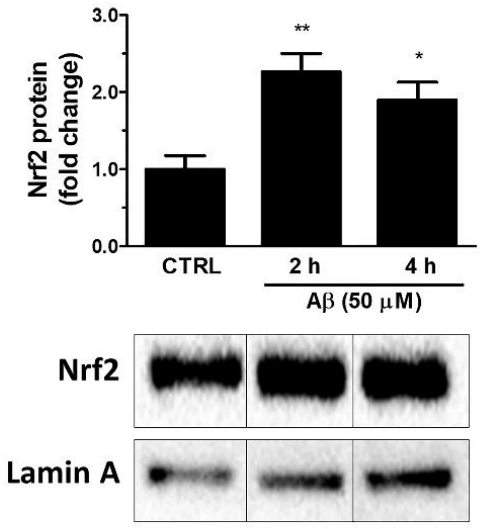
Figure 1. Effects of A β 25-35 on nuclear translocation of Nrf2 in U373 cells. Cells were treated with A β 25-35 (50 µ M) for 2 and 4 h. The histograms show the densitometric analysis of the Western blots for each sample. Data are calculated relative to the housekeeping gene (i.e., nuclear lamin A) content and are the means ± SEM from three separate experiments, each performed in duplicate. One-way ANOVA, followed by Bonferroni’s test, was used to define significant differences. * p ≤ 0.05 vs. CTRL; ** p ≤ 0.01 vs. CTRL.